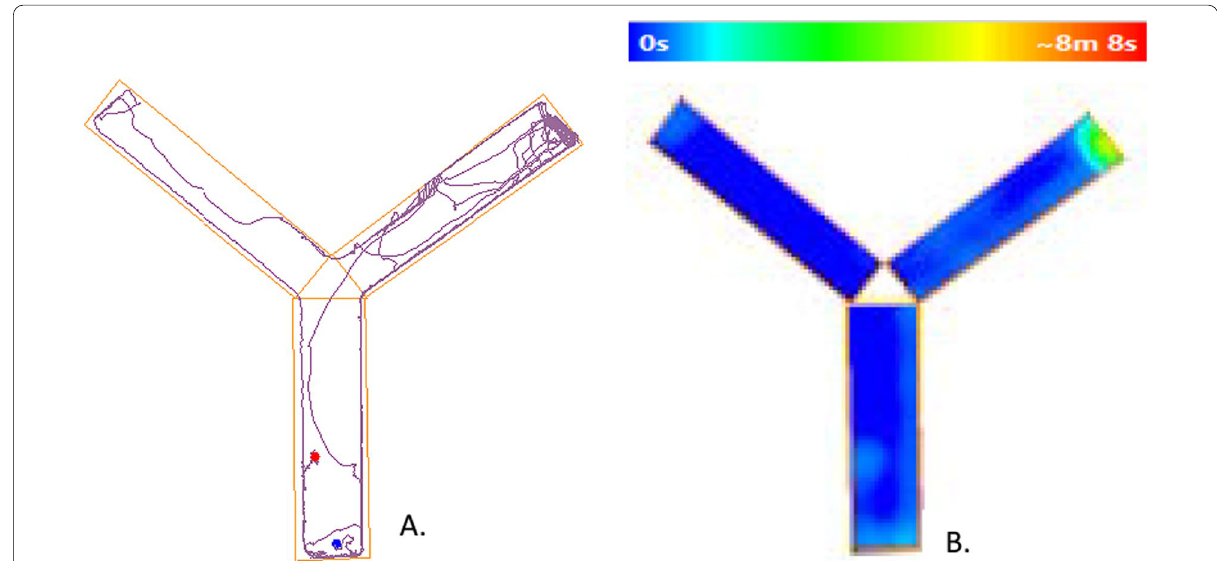
Fig. 8 Track ( A ) and heat ( B ) map visualizing the time spent of 2nd instar individual C. carnea in movement area for ten minutes. Vertical arm is a release arm. Y-maze provided with eggs of related parents at left arm and of un-related parents at right arm. Blue and orange spots are starting and ending point, respectively